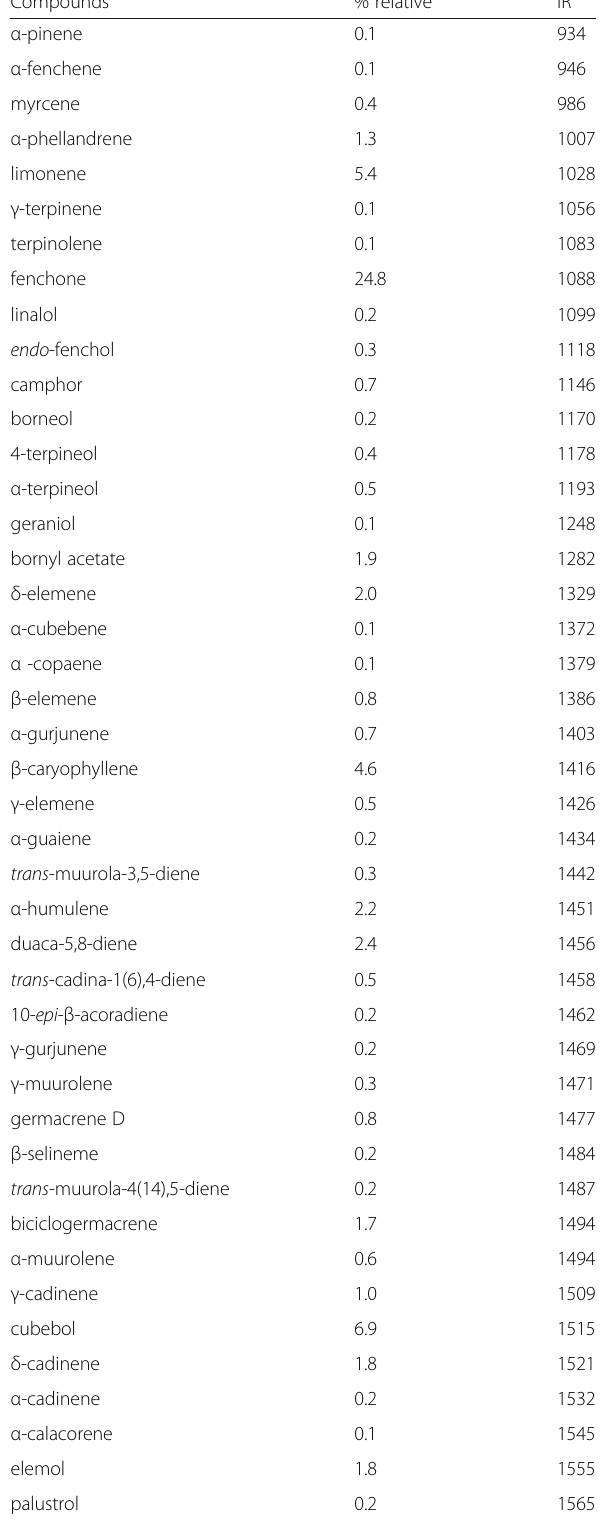
Table 1 Chemical composition of essential oil from aerial parts of Mesosphaerum sidifolium Compounds